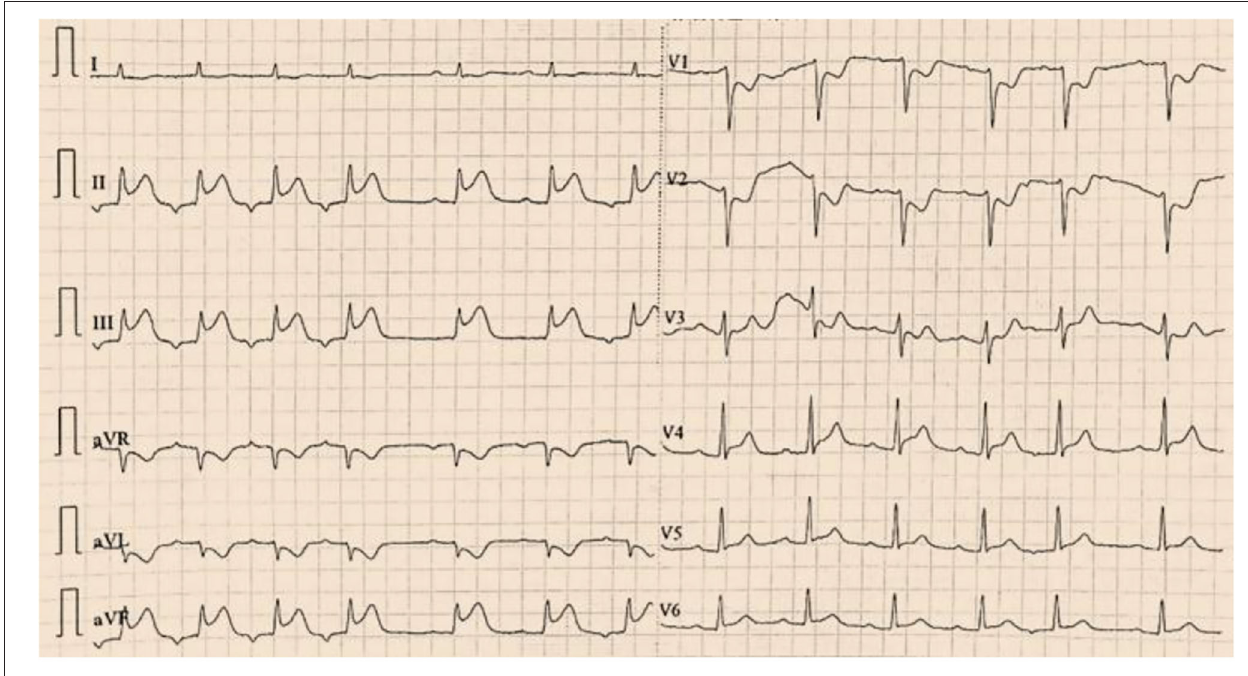
FIGURE 2 | The first twelve-lead electrocardiogram indicated ST-segment elevation in leads II, III and aVF.